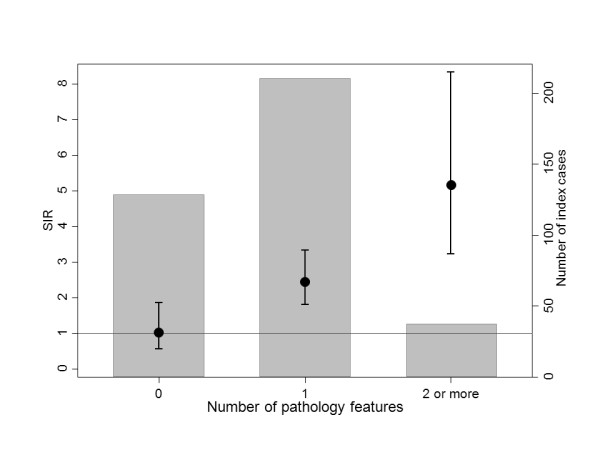
SIRs (95% CIs) for mothers and sisters of 375 index cases by number of pathology features. Grey areas represent the proportion of index cases with given number of features.